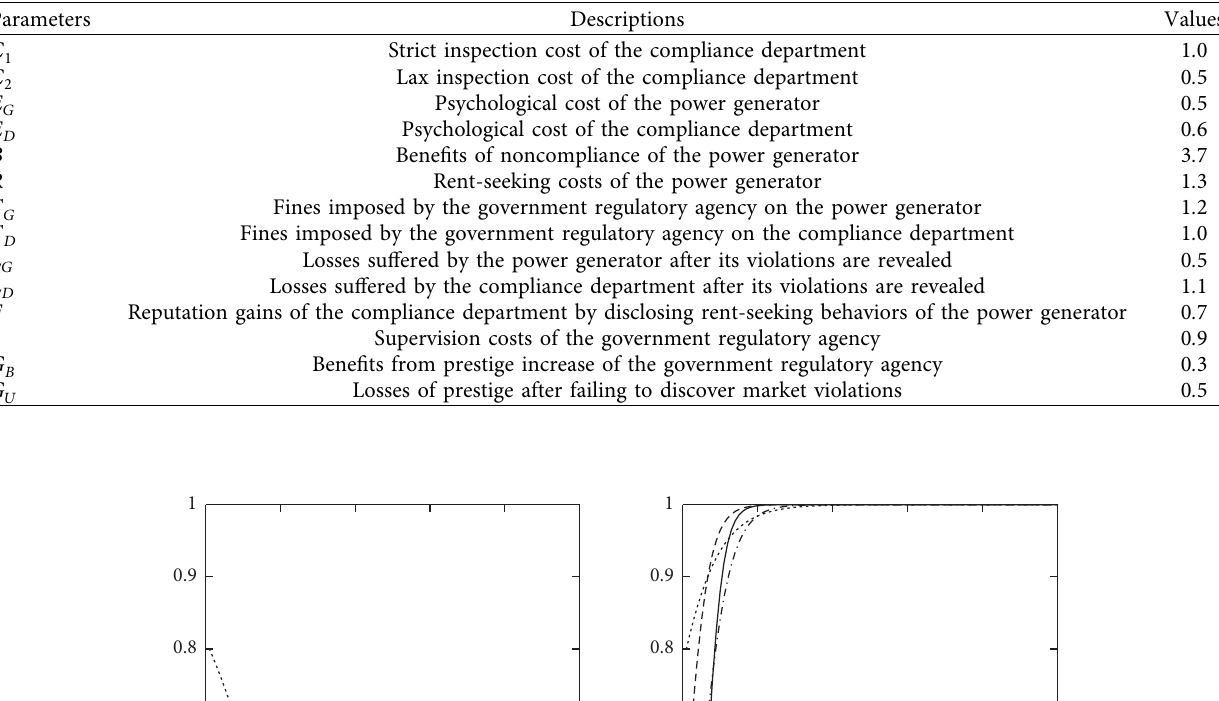
Table 8: The value of parameters.